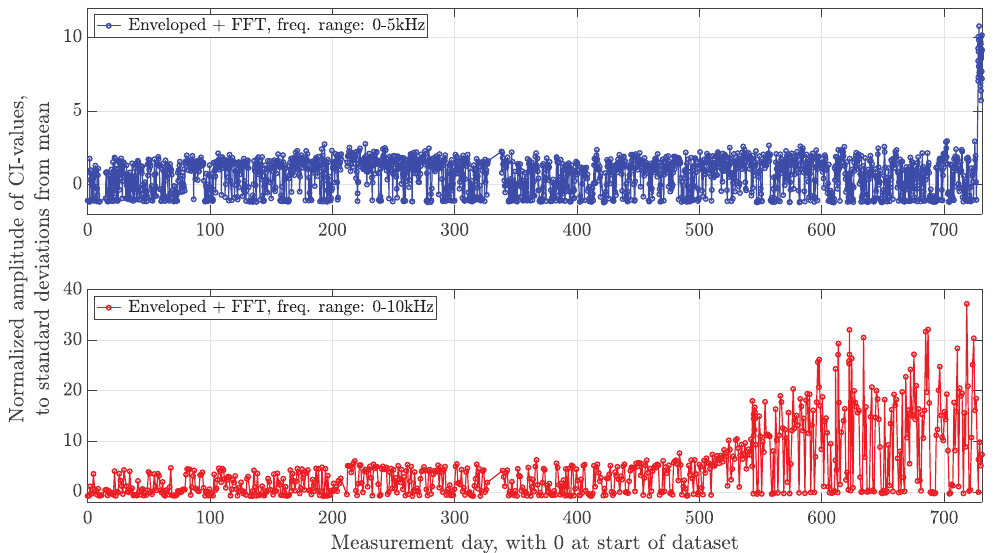
Figure 2. Normalized CI-values from FFT spectra in blue and WPT in black on enveloped measure- ments from failure case 1 in ( a ) and failure case 2 in ( b ).